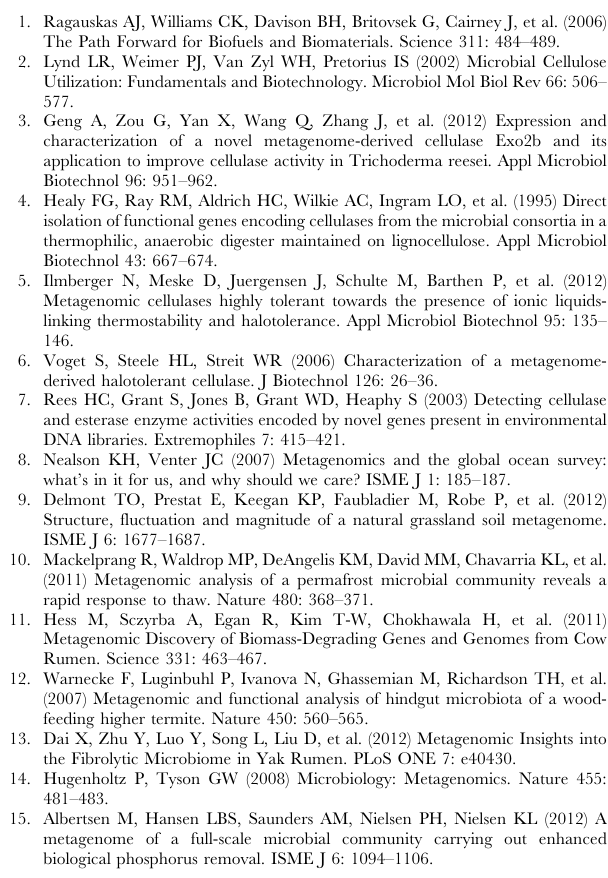
Figure S6 Relative distribution of different metabolism subsystems of genus Clostridium and Thermoanaero- bacterium in the enriched thermophilic cellulolytic sludge metagenome using SEED Carbohydrates Metab- olism subsystems in the MG-RAST server. Figure S7 Gel analysis results of the predicted putative genes. Gene size of each band was shown in unit of amino acids. The incorrect gene size was marked in red frame. Table S1 Velvet assembly statistics. Table S2 Properties of the 10 predicted carbohydrate- active enzyme candidates tested for assembly authority.